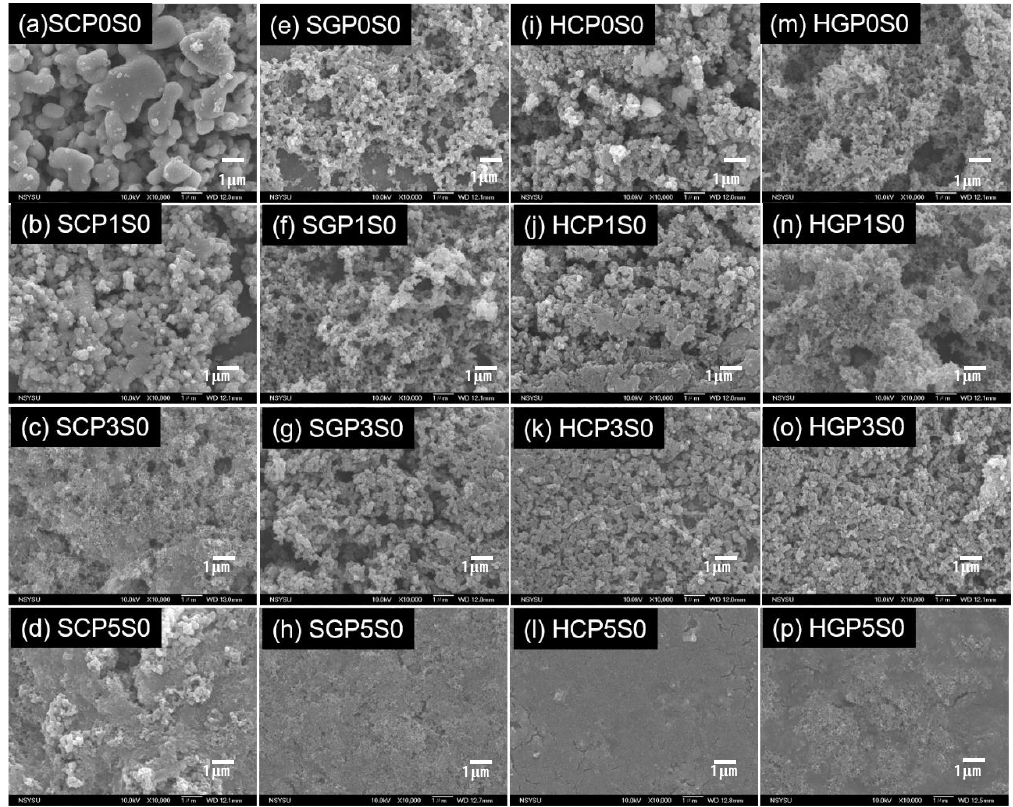
Figure 3. The scanning electron microscopy (SEM) images (10,000×) of immobilized polyaniline- Carbon nanotubes/TiO 2 (PANi-CNT/TiO 2) photocatalysts. ( a ) SCP0S0; ( b ) SCP1S0; ( c ) SCP3S0; ( d ) SCP5S0; ( e ) SGP0S0; ( f ) SGP1S0; ( g ) SGP3S0; ( h ) SGP5S0; ( i ) HCP0S0; ( j ) HCP1S0; ( k ) HCP3S0; ( l ) PANi-CNT/TiO 2 photocatalysts.